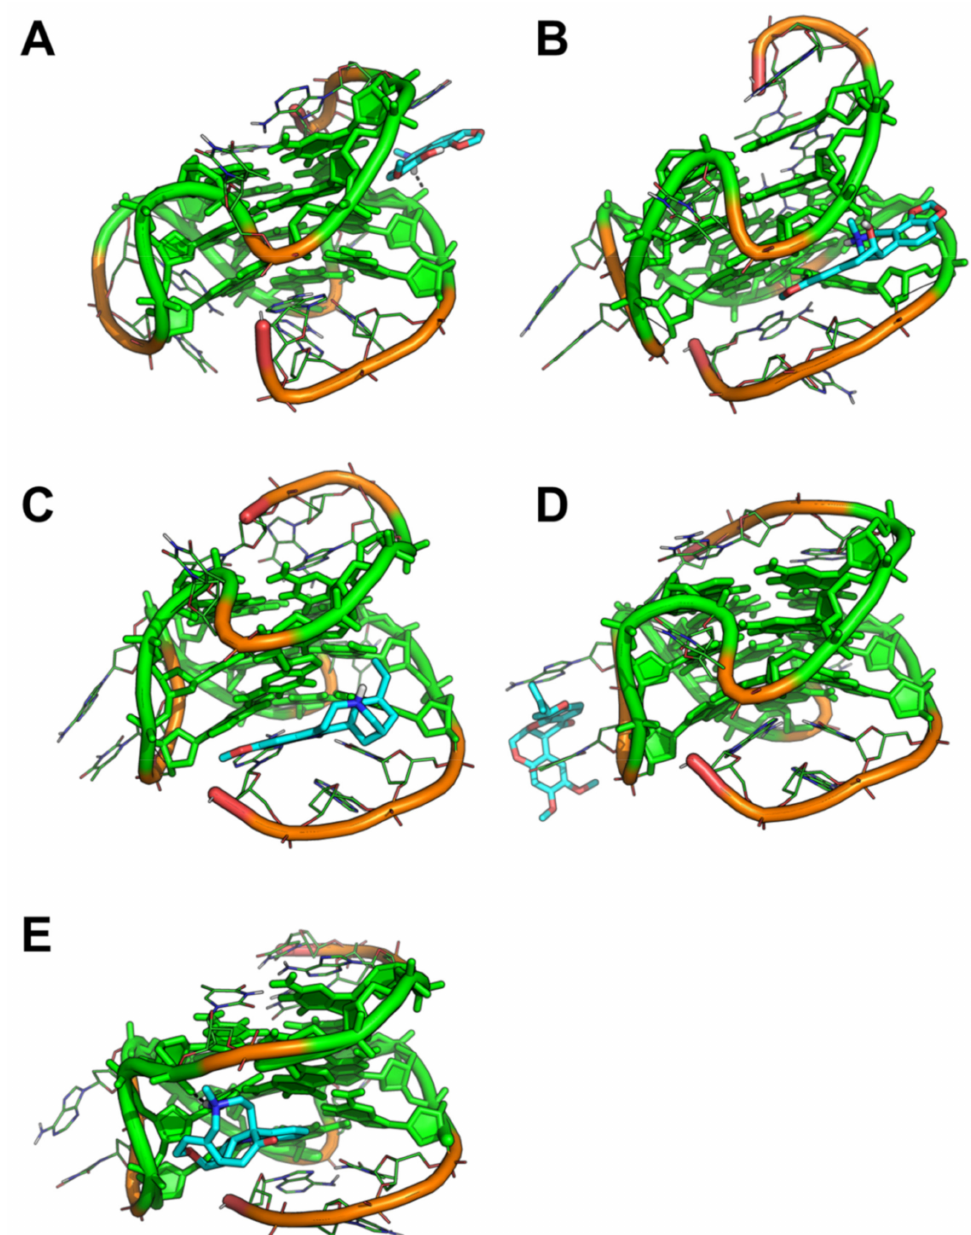
Figure 4. Representative binding conformation of selected ligands to c-myc G4 extracted from MD trajectories. ( A ) c-myc G4/Bulbocapnine; ( B ) c-myc G4/Chelidonine; ( C ) c-myc G4/Ibogaine; ( D ) c-myc G4/Rotenone; ( E ) c-myc G4/Vomicine. The G4 is shown as lines and cartoon. G nucleotides forming G-quartets are shown as green sticks with filled rings. Small molecules are shown as cyan sticks. Metal ions and water molecules have been omitted for the sake of clarity. c-myc G4/ligand polar interactions are highlighted by black dashed lines. The same orientation of each c-myc G4/ligand complex is shown, which was obtained by structural alignment on the G4 phosphate